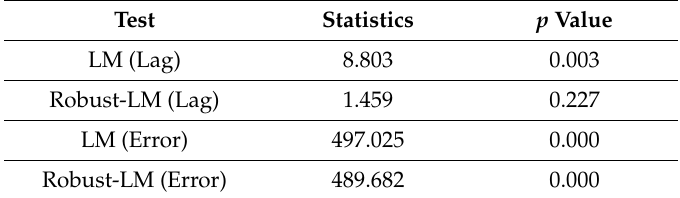
Table 5. LM and robust LM test results of space lag e ff ect and space error e ff ect.